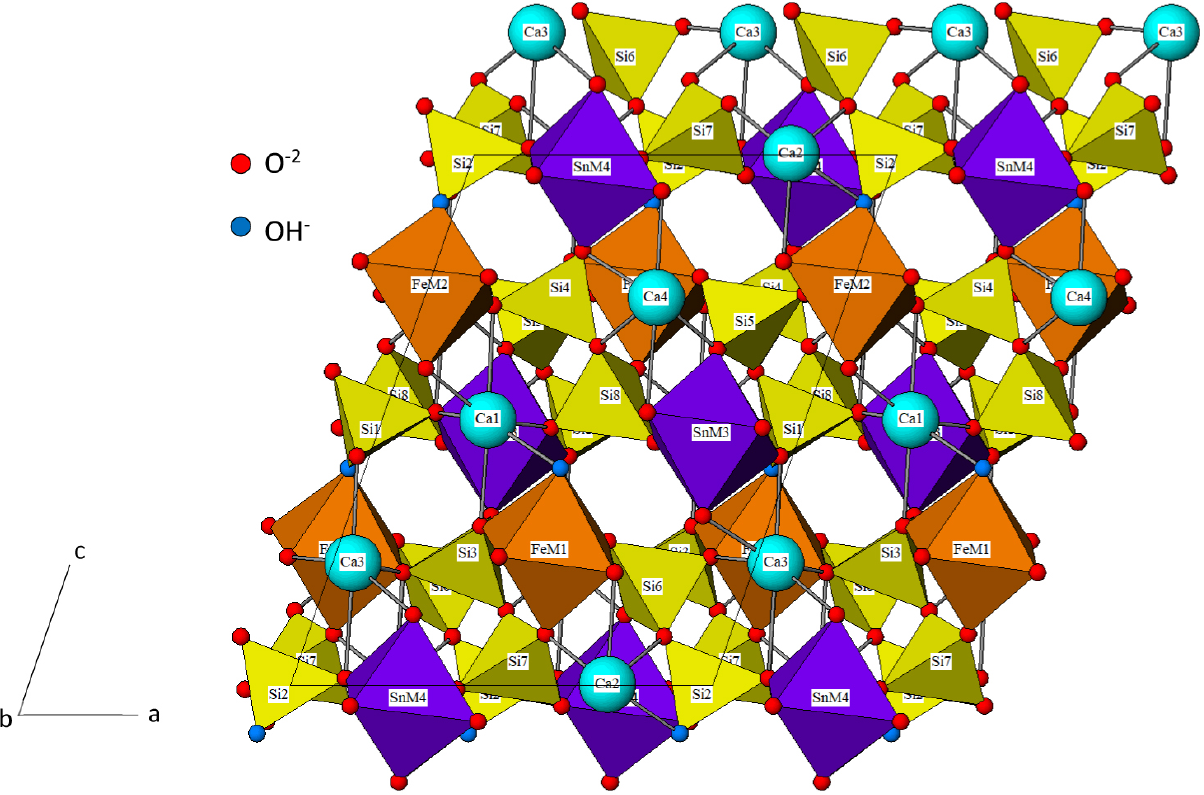
Figure 6. Structure of silesiaite based on the structure of kristiansenite (Ferraris et al., 2001; Evans et al.,